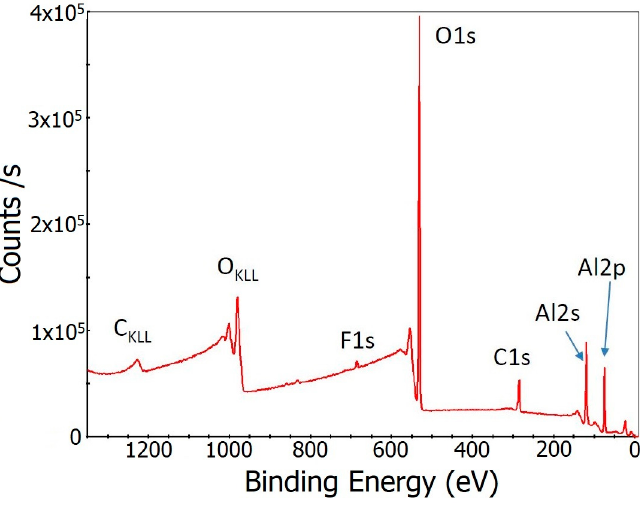
Figure 6. XPS spectra for PEALD Al 2 O 3 ultra-thin fi lm at 250 °C.